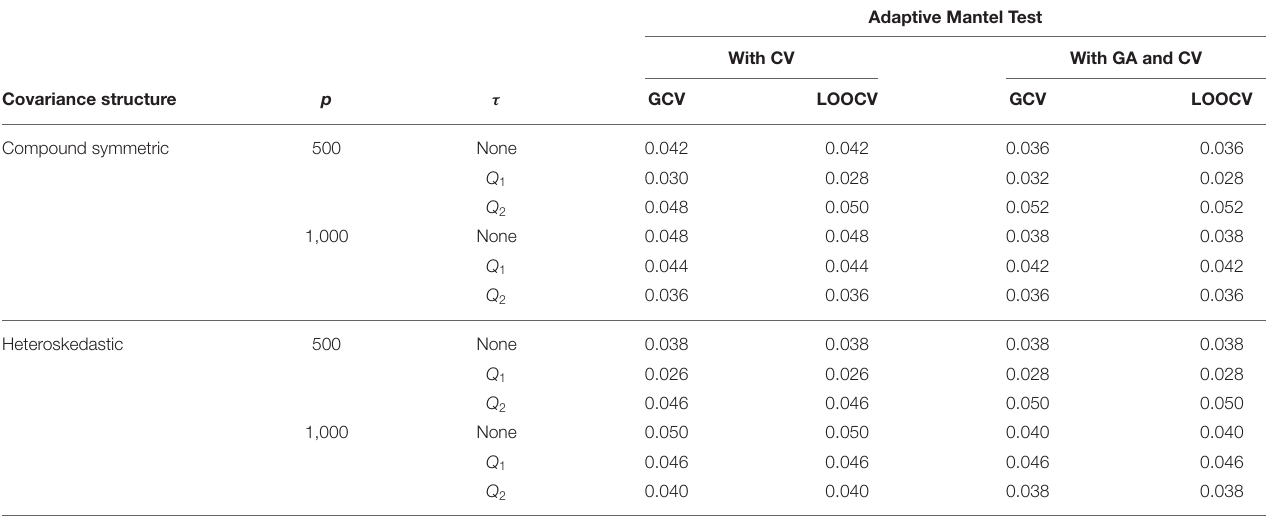
TABLE 1 | Numerical comparison of the Type I error of Adaptive Mantel test (i) with cross-validation vs. (ii) with Gamma approximation and cross-validation using the simulated data with n = 350, error standard deviation σ = 0.50 and β = 0